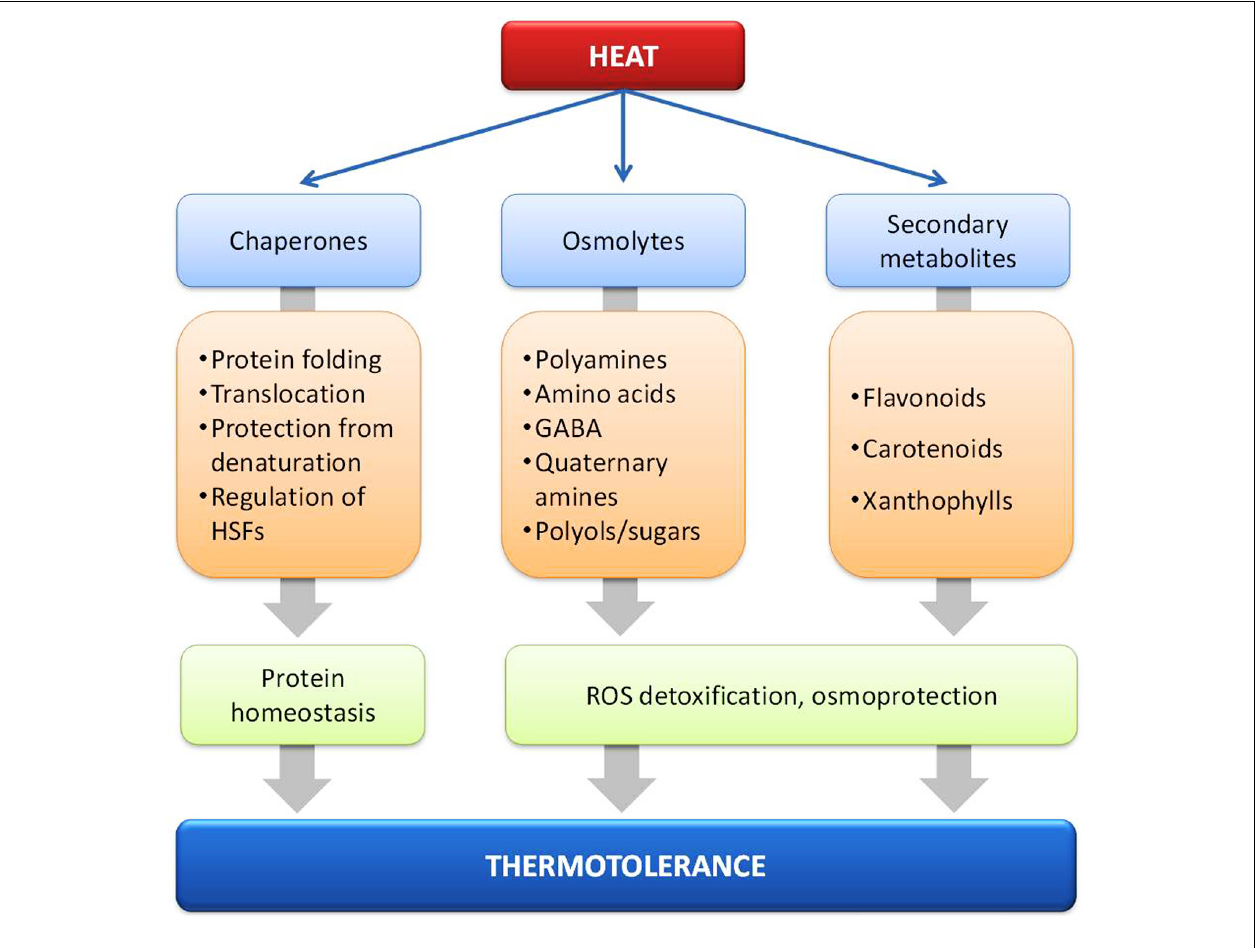
FIGURE 2 | Molecular chaperones and metabolites such as osmolytes and secondary metabolites implicated in heat stress response and